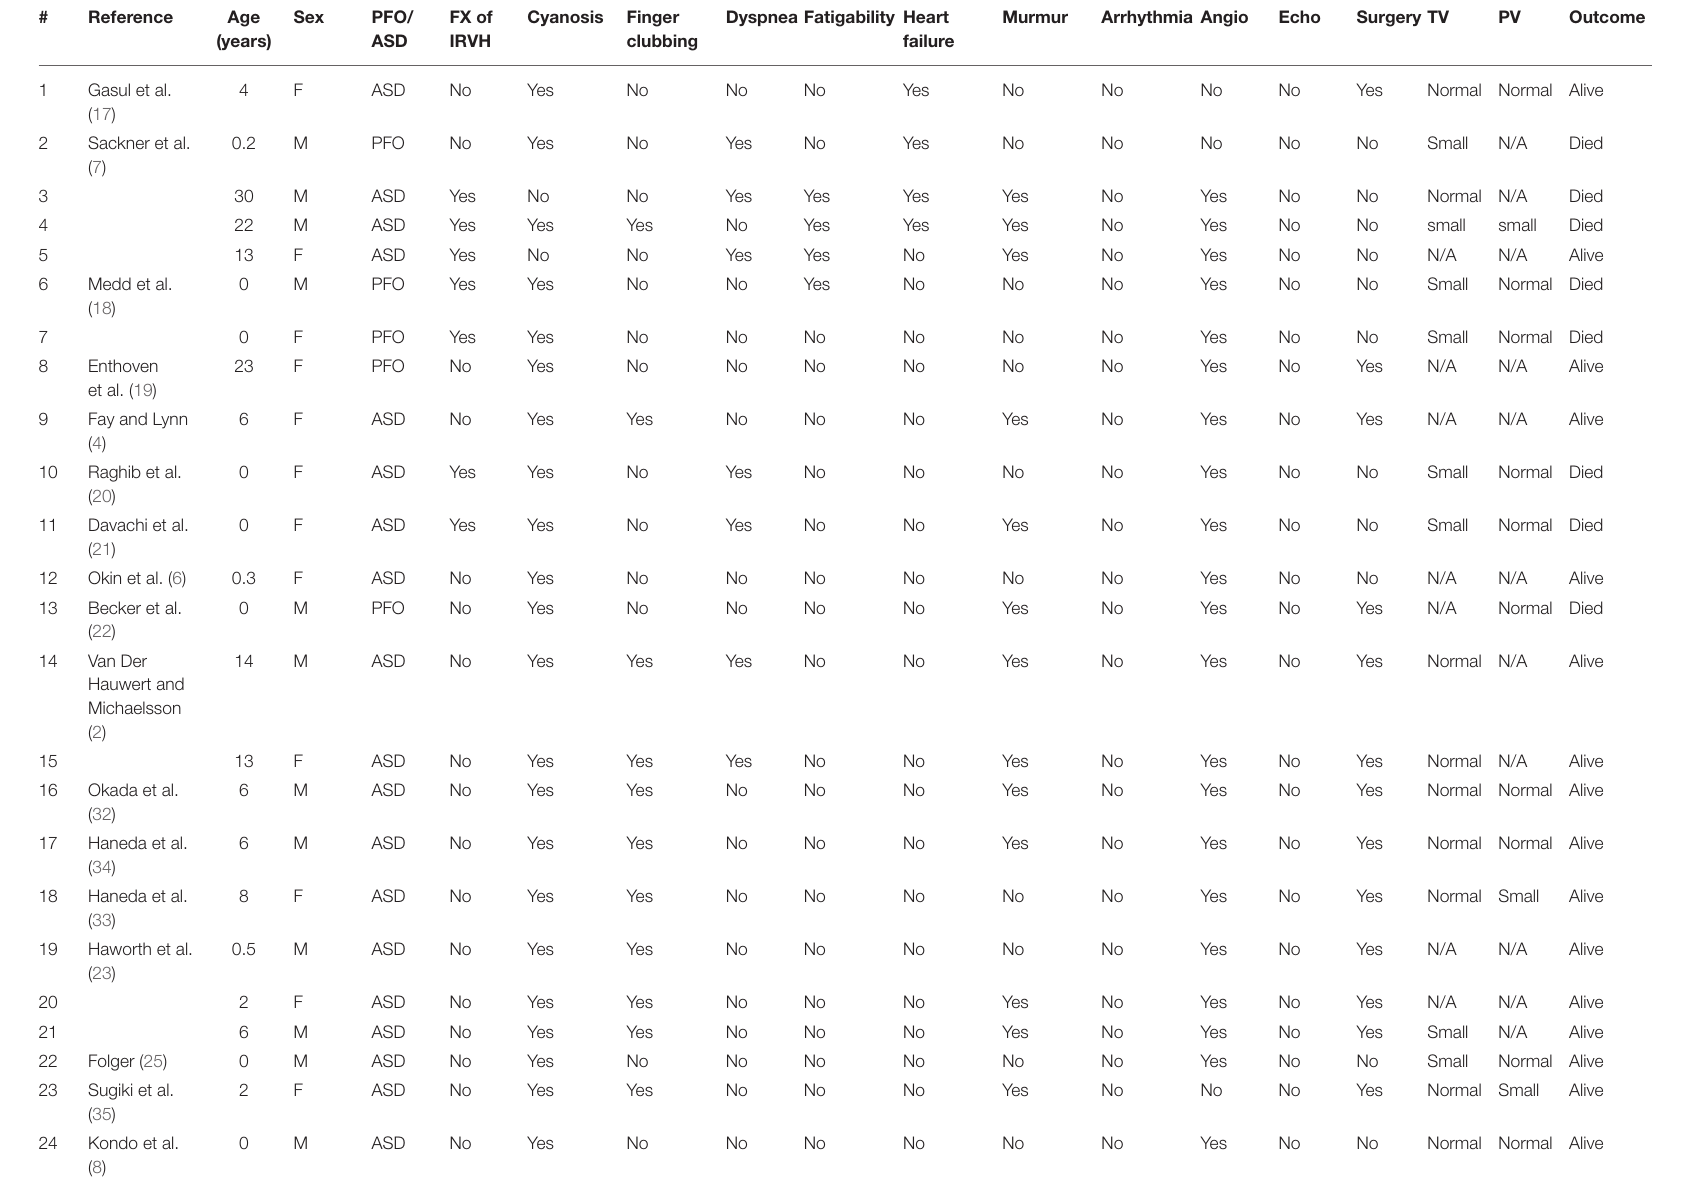
TABLE 1 | Characteristics of 54 IRVH cases from 31